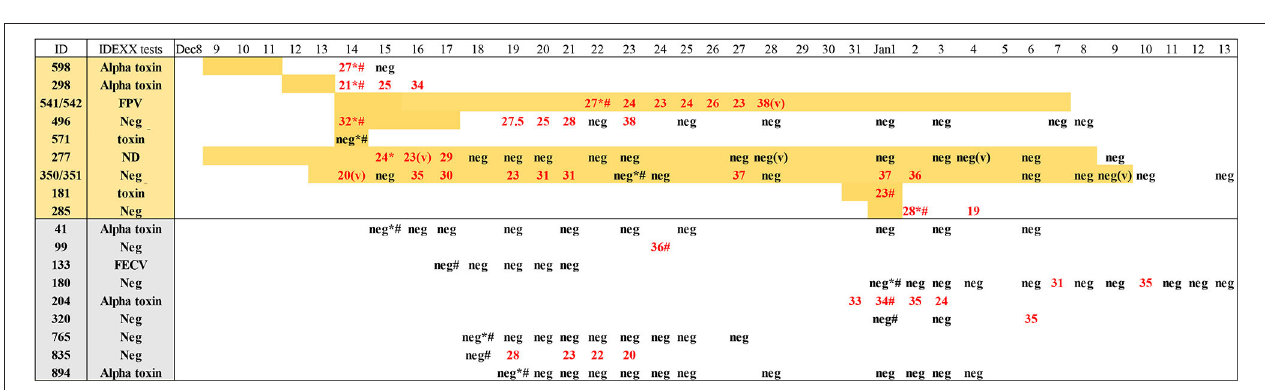
FIGURE 2 | Real-time RT-PCR for feline astrovirus of samples from affected and control animals showing C t numbers and results of IDEXX testing for feline diarrhea pathogens. Samples of all feces, unless labeled ( v ) for vomit; numbers in red indicate C t for astrovirus RT-PCR. Negative for C t > 40. Number symbol , sample used for IDEXX testing. Asterisk , sample used for metagenomic next-generation sequencing (mNGS). Yellow highlight indicate days of vomiting. ND , not done. ( Supplementary Table 1 , clinical signs). Cats tended to either multiple longitudinal fecal samples were available, the first sample was analyzed. Of the clinically affected cats, three were weakly positive for C. perfringens alpha toxin gene, two were weakly positive for FPV (one sample was a pool of feces from a pair of kittens, no. 541/542), and one was positive for FECV ( Figure 2 , IDEXX tests column). The C. perfringens alpha toxin gene can be detected at low levels in both healthy and diarrheic cats and is not considered a primary cause of enteric illness in cats (32, 46). Feline panleukopenia can also be detected in feces by PCR after modified live vaccination or field infection (47); neither FECV nor FPV was considered a likely cause for this outbreak based on their expected clinical patterns and the detection of each in only one (FECV) or two (FPV) affected cats. The detection rates for the C. perfringens alpha toxin and FECV were similar for both the affected and control cats in this study ( Figure 2 , IDEXX test column). Screening for common infectious agents using the comprehensive feline diarrhea PCR panel therefore did not yield a potential causative agent for the